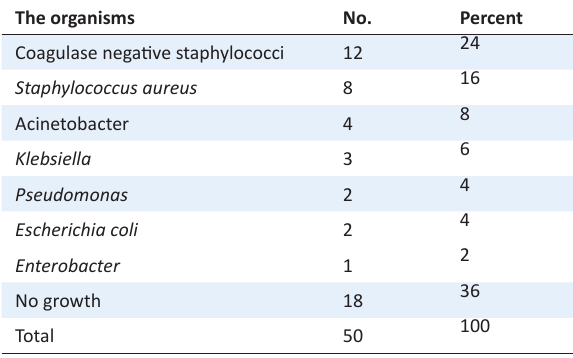
Table 2. The frequency of organisms leading to catheter-related blood stream infection in patients under hemodialysis The organisms